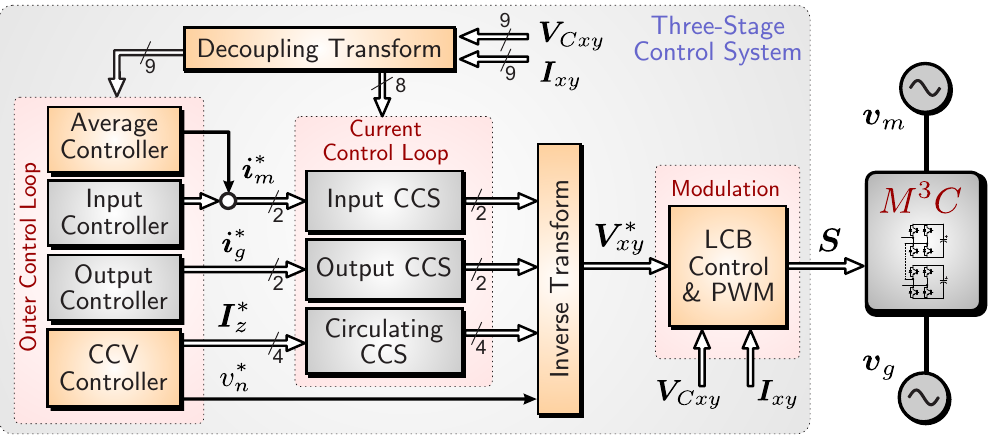
Figure 4. Three-stage control system of the M 3 C